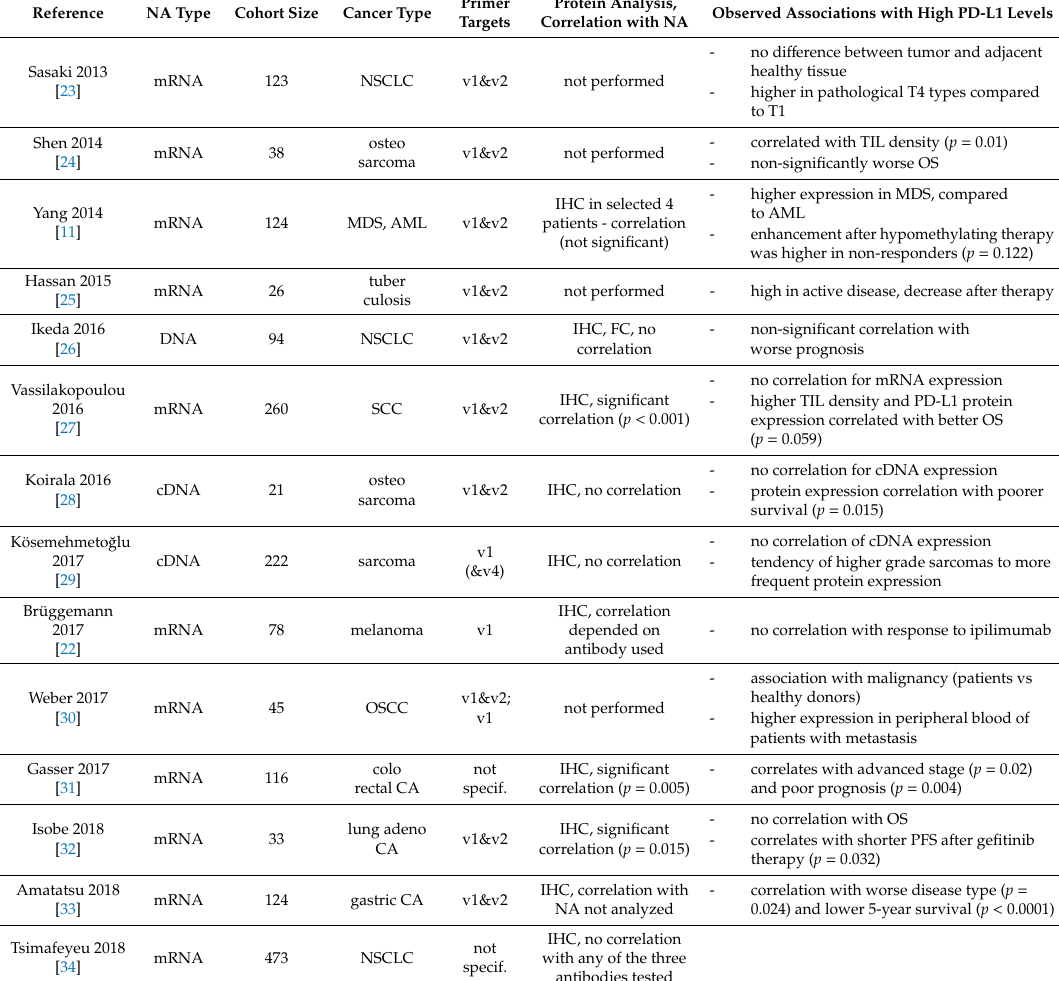
Table 1. Review of published studies reporting PD-L1 transcript